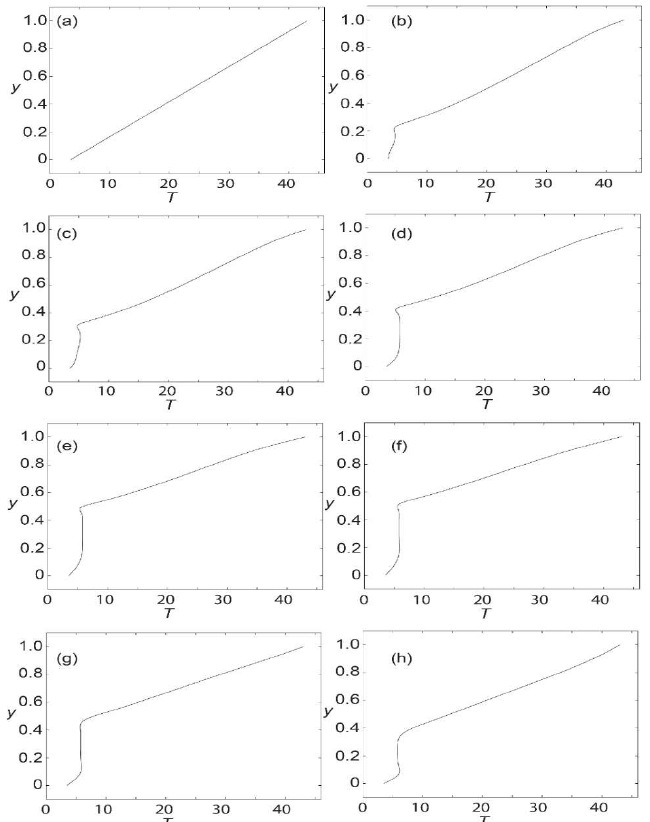
Figure 6. Temperature profiles at various parts of the channel subjected to B o = 8 T and Re = 250 at x = ( a ) 0; ( b ) 2.5; ( c ) 2.6; ( d ) 2.8; ( e ) 3.1; ( f ) 3.5; ( g ) 4.5; and ( h ) 5.5.